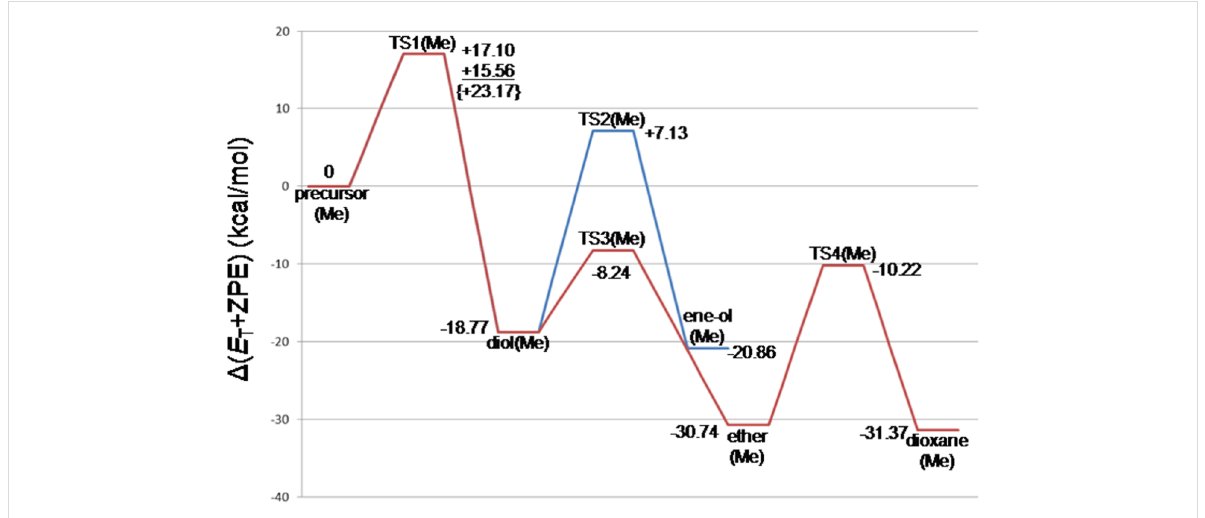
Figure 2: Energy changes (in kcal/mol) of the propene Prins reaction calculated by B3LYP/6-311+G(d,p) SCRF=(PCM, solvent = mwater)// B3LYP/6- 31G(d) ZPE. The corresponding geometries are shown in Figure 1 and Figure S1. E T stands for the total energy. At TS1(Me), while B3LYP/6- 311+G(d,p) SCRF=PCM and M06-2X/6-311+G(d,p) SCRF=PCM energies are similar, the { ω B97XD/6-311+G(d,p) SCRF=PCM} energy seems to be overestimated in spite of the similarity of the three geometries in Figure